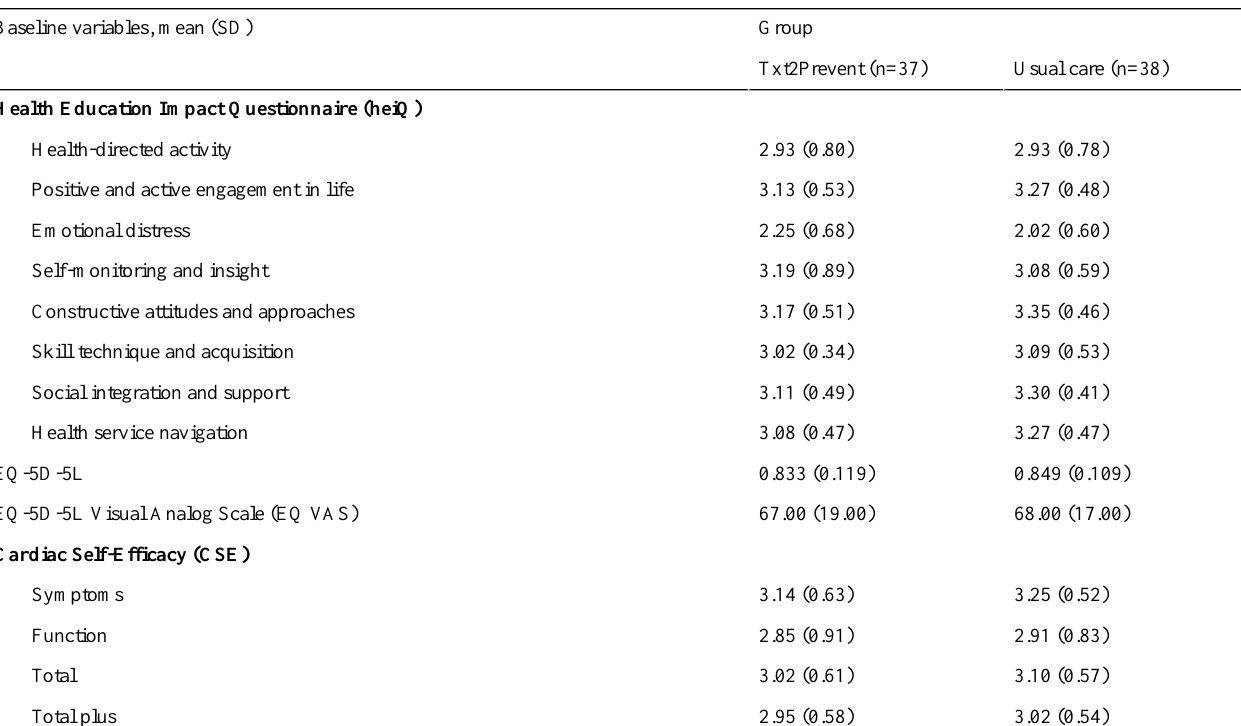
Table 3. Baseline questionnaire scores, by group.